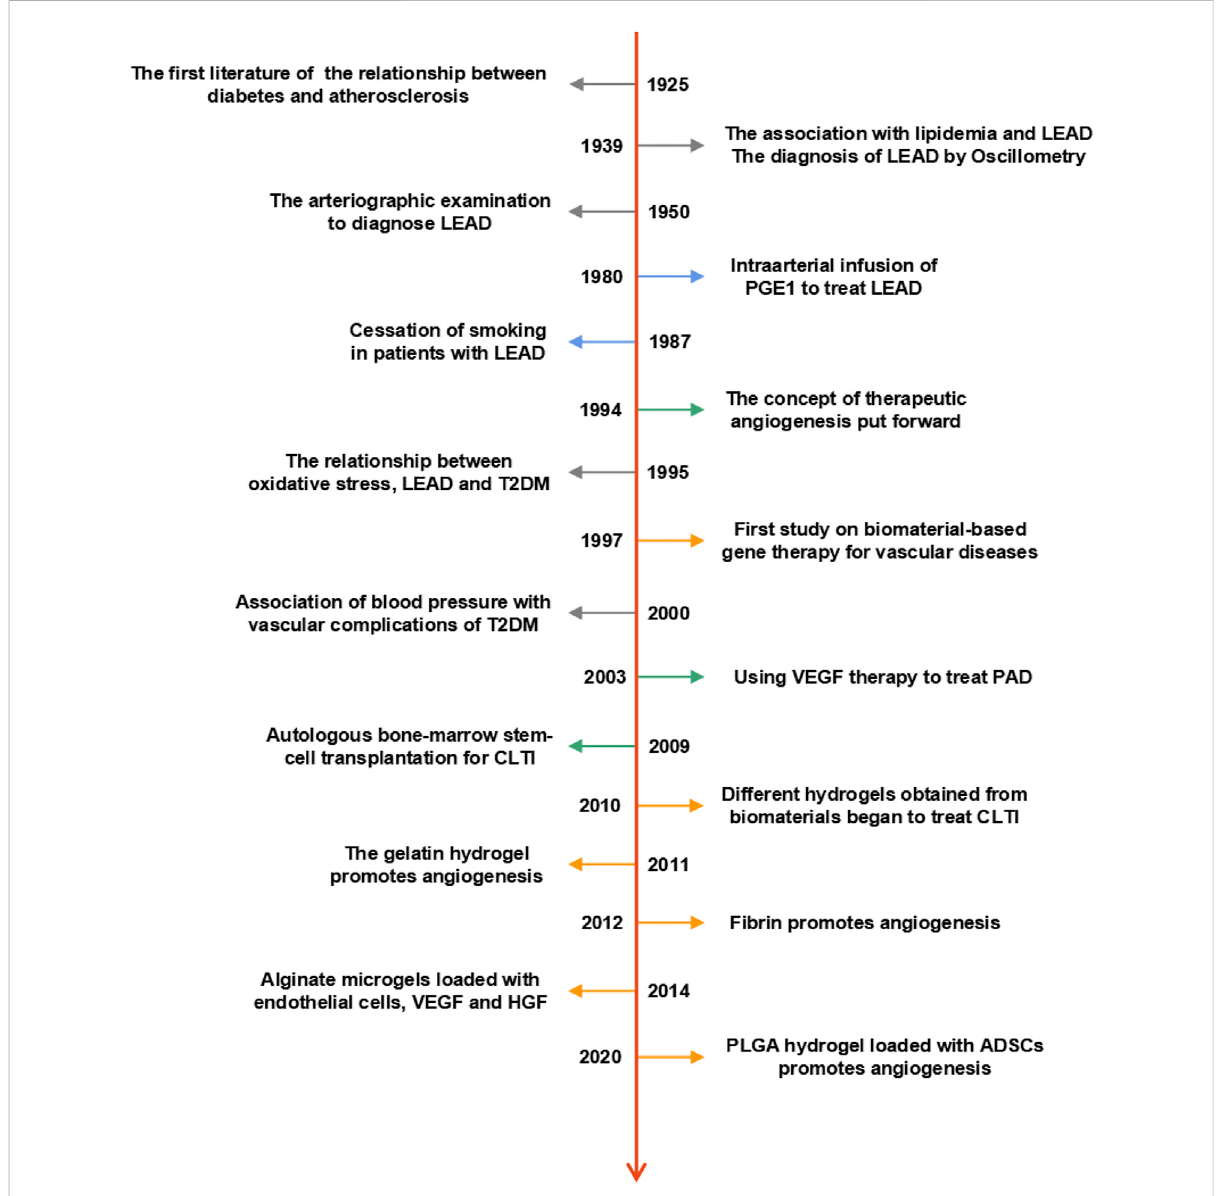
FIGURE 1 Timeline of preclinical and clinical research on LEAD. The dates listed indicate essential milestones in the history of